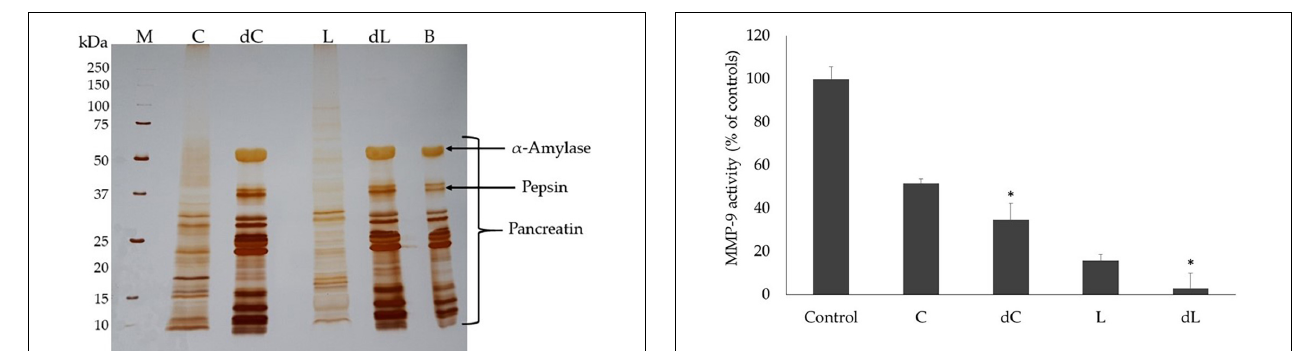
FIGURE 3 | The effect of the beverages and digesta extracts (L, lupin; dL, lupin digesta ; C, chickpea; dC, chickpea digesta ) on MMP-9 gelatinolytic activity was measured by the DQ-gelatin assay. MMP-9 activity is expressed as relative fluorescence as a % of control and corresponds to the means of at least three replicate assays ( n = 3) ± SD. * p <